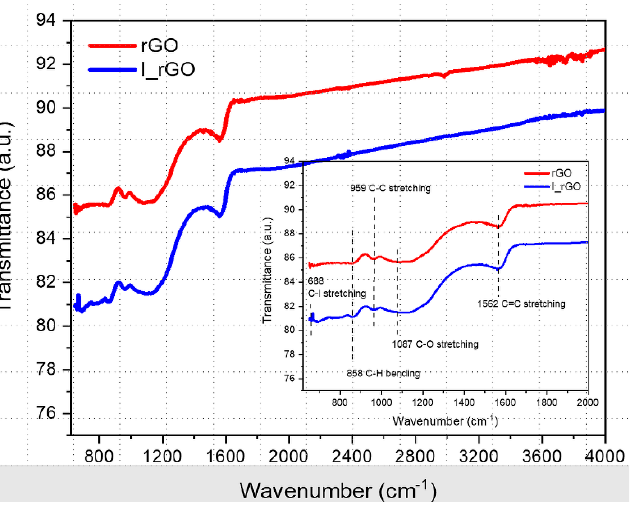
Figure 6. Overlaid ATR − FTIR rGO and I/rGO spectra with the fingerprint zone in the inset.